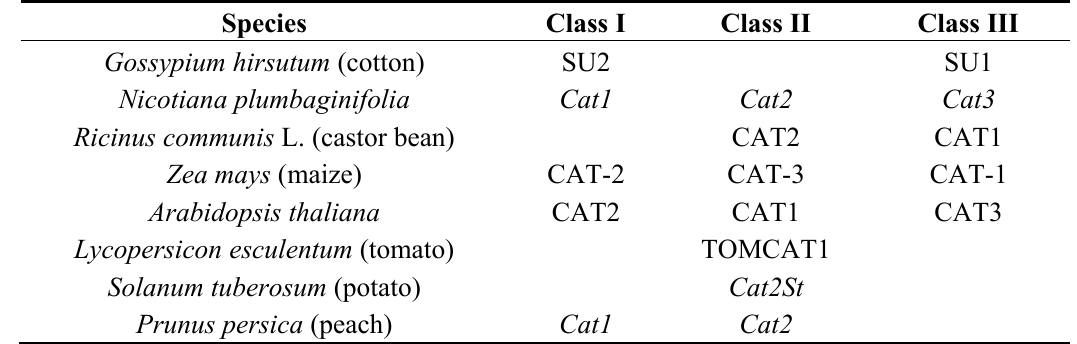
Table 2. Classification of plant catalases based on expression properties a . Modified from Willekens et al .